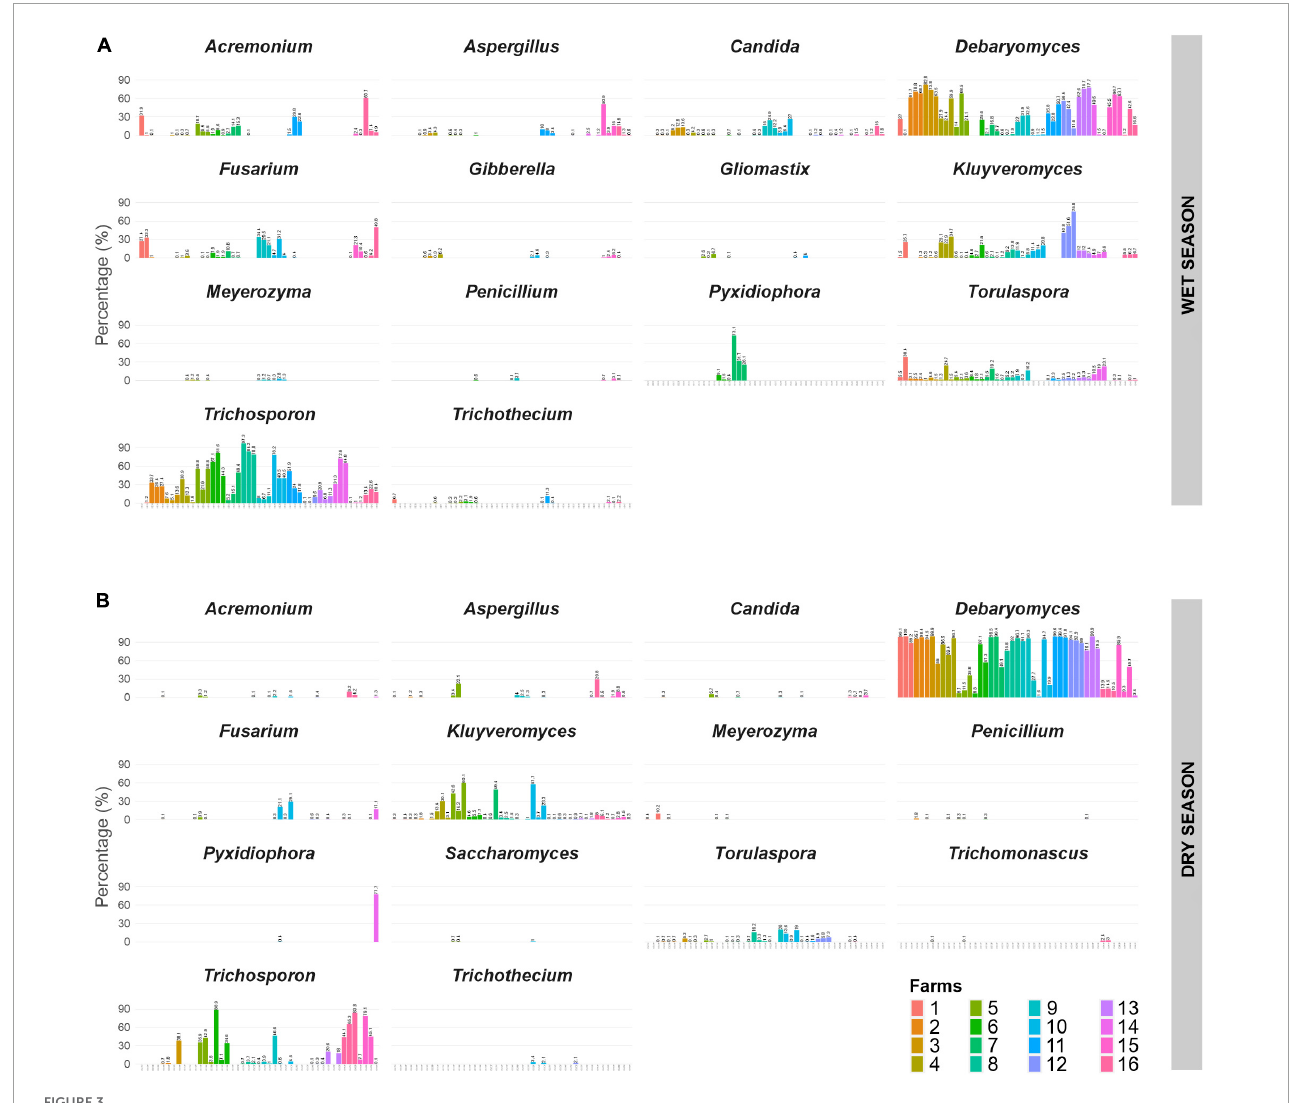
FIGURE3 Relative abundance of the predominant fungi genera in Canastra cheeses produced during the wet season (A) and the dry season (B) , from 16 cheese-producing farms (indicated by different